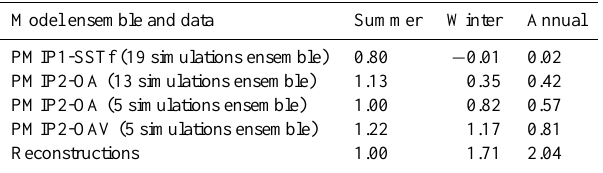
Table 3. Summary of seasonal changes in temperature ( ◦ C) av- eraged over the locations of available reconstructions. Ensem- ble means of nineteen PMIP1-SSTf simulations, thirteen PMIP2- OA simulations and five PMIP2-OAV simulations (The MRI- CGCM2.3.4nfa-OAV is excluded) are given, as well as an ensemble mean for five PMIP2-OA simulations to compare with their OAV